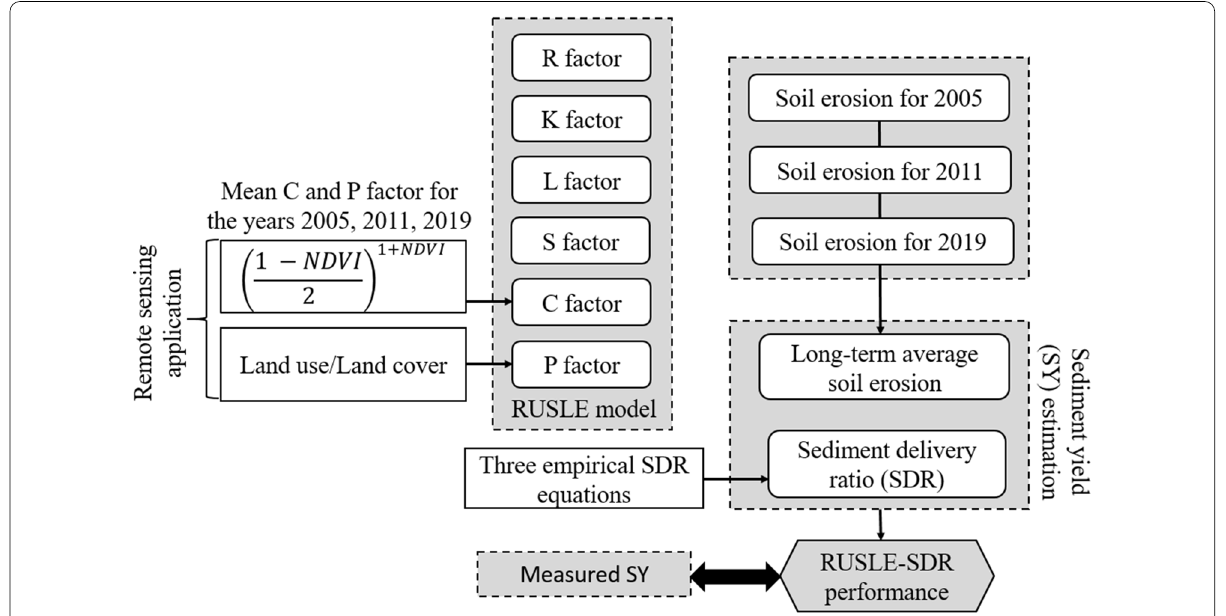
Fig. 2 The implementation flowchart of this